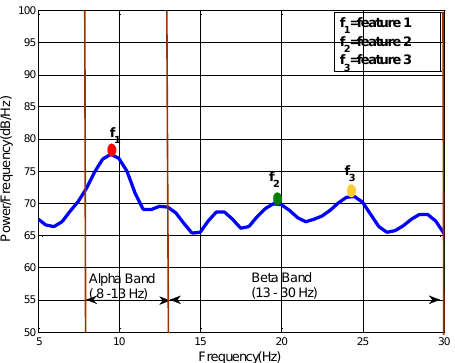
Figure 3. Proposed feature extraction scheme. The curve indicates the PSD of EEG in alpha and beta bands. We select the highest PSD peak value in the alpha band and first two highest PSD peak values in the beta band as the